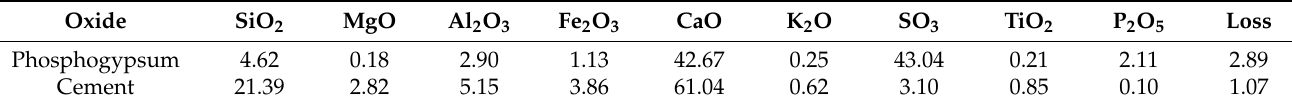
Table 1. Chemical composition of phosphogypsum and cement (wt. %).